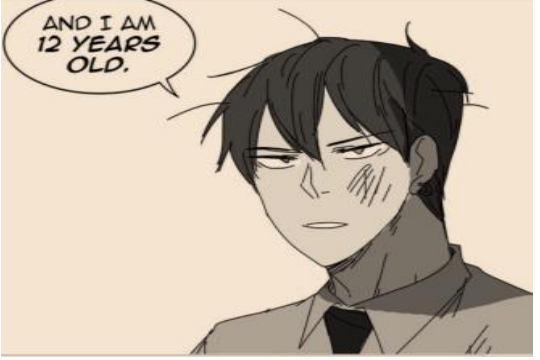
Picture 1. Original Speech-balloon